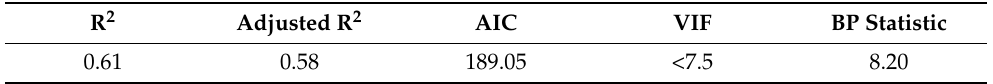
Table 6. OLS model test results.